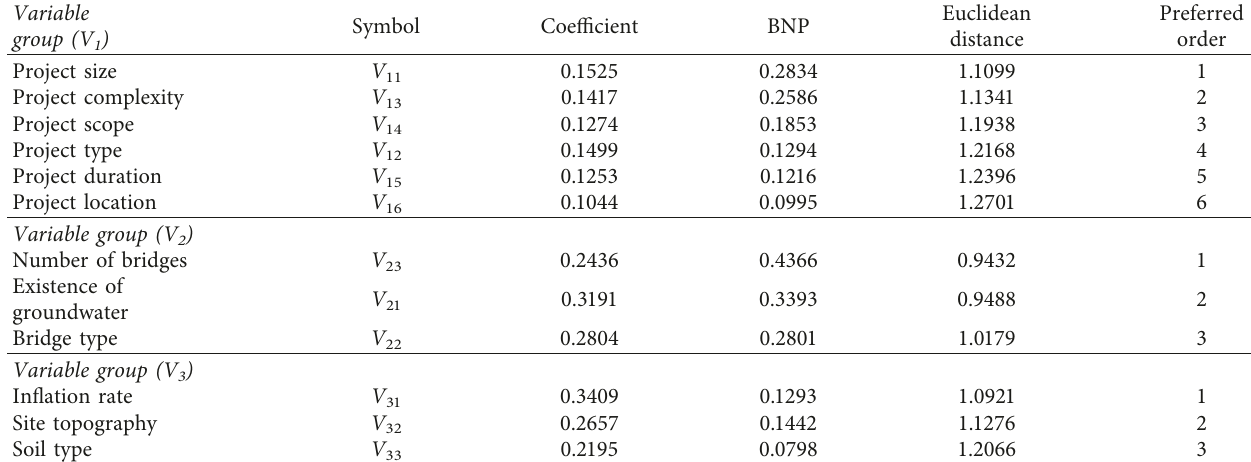
Table 8: Selection order of input variables and distance to ideal input.